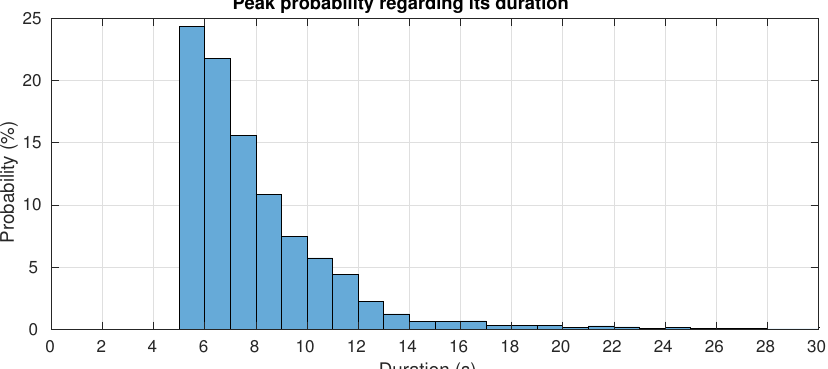
Figure 20. Histogram of peak duration during 25 equally spaced days in 2017 representing the probability in bins of 1 s with a total number of samples of around